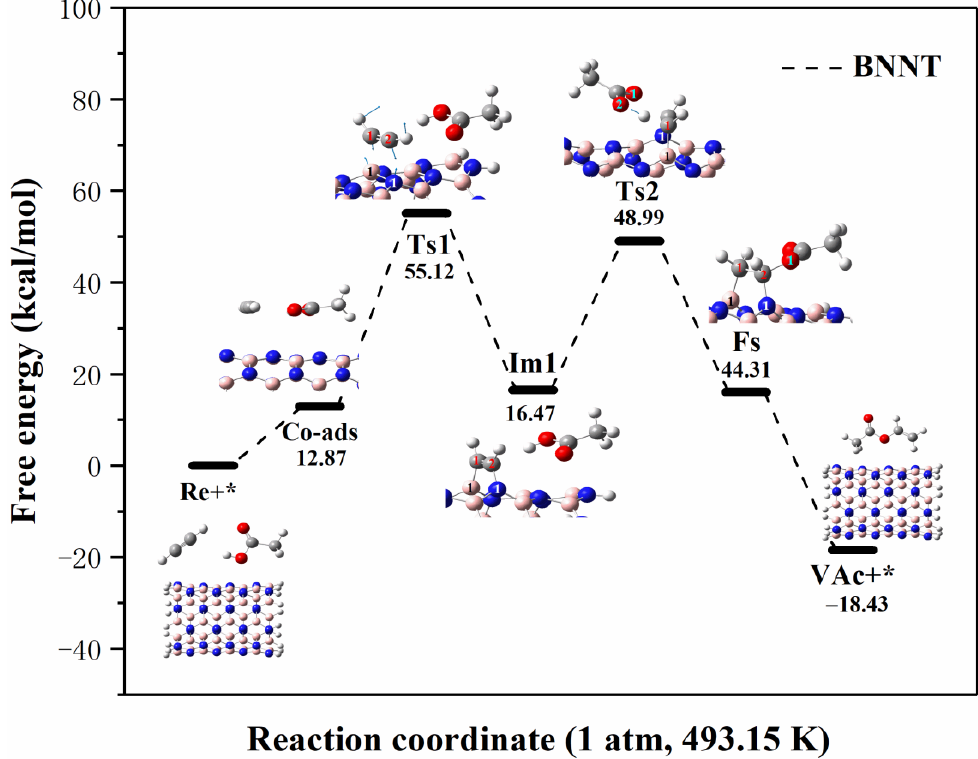
Figure 7. Reaction process and energy change of C 2 H 2 and CH 3 COOH on BN nanotubes at 1 atm and 493.15 K (Re stands for reactant, * stands for catalyst, Co-ads stands for co-adsorption structure, Ts stands for transition state, Im stands for intermediate state, Fs stands for final state structure, VAc stands for vinyl acetate).